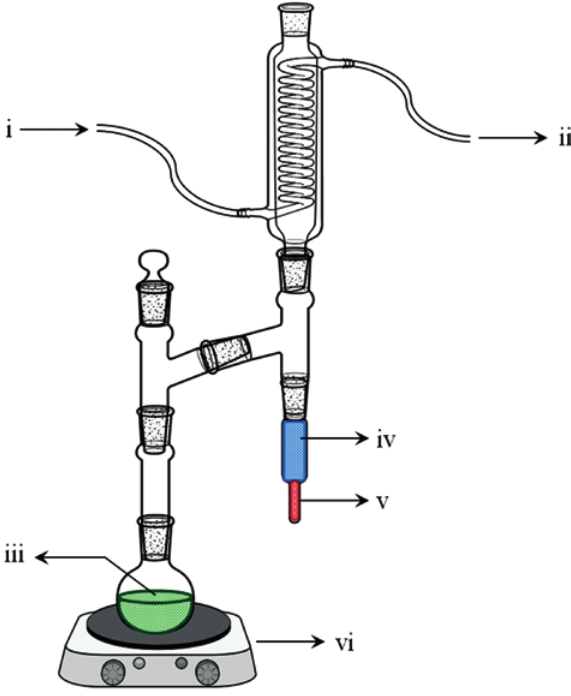
Figure 1: Mounted set-up consisting of (i) cold water inlet, (ii) cold water outlet, (iii) reactants, iv) toluene, (v) water and (vi) a conven- tional